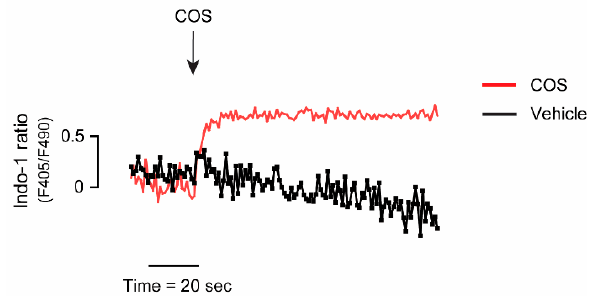
Figure 5. Effect of COS on the level of intracellular calcium. Representative tracing of indo-1 fluorescence ratio (emitted at 405 nm and 490 nm; F405/F490) was shown. After indo-1 loading, MDCK cells were suspended in buffers supplemented with Ca 2+ (1 mM). During continual measurement of indo-1 fluorescence, COS (100 µg/mL) or 1% acetic acid (vehicle control) was added into the solutions.